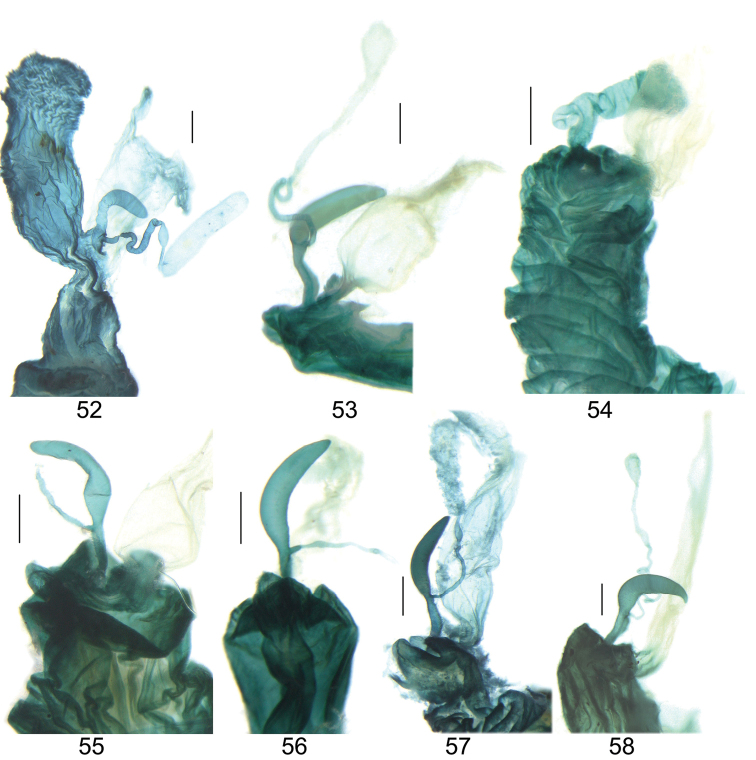
Female reproductive system, 52
P.
gibbosus sp. n., Xizang (Mêdog) 53
P.
elegans sp. n., Xizang (Mêdog) 54
P.
dux Andrewes, Yunnan (Jinghong) 55
P.
obscuratus sp. n., paratype, Guizhou (Fanjingshan) 56
P.
acutidens sp. n., Yunnan (Longchuan) 57
P.
ornatus
formosanus Dupuis, Taiwan (Yilan) 58
P.
amplus Andrewes, Myanmar (Putao). Scale bars: 0.2 mm.